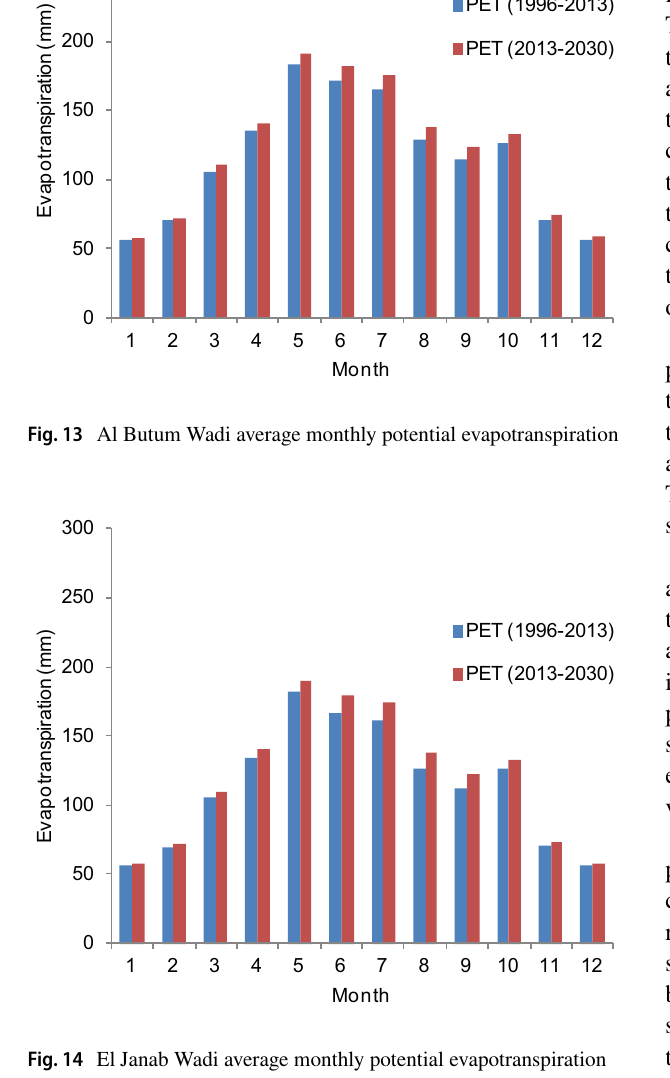
Fig. 14 El Janab Wadi average monthly potential